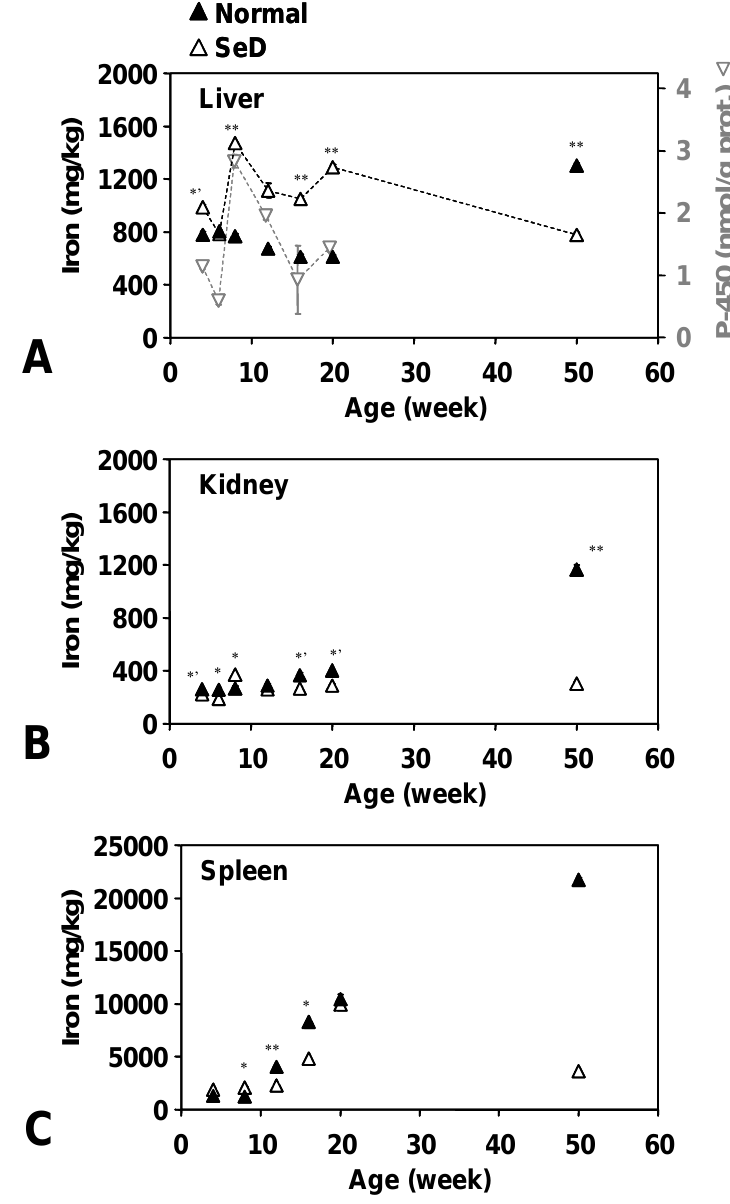
Figure 4. Dependence of Fe contents in the (A) liver, (B) kidney, and (C) spleen of normal and SeD rats on the age of rats. Values are indicated as the mean ± SD of three measurements. * , *’ , and ** indicate a significant difference between normal and SeD groups at p < 0.05, p < 0.01, and p < 0.001, respectively. Gray inverse triangles in (A) indicate cytochrome P-450 activity in the SeD rat liver microsome. Values are indicated as the mean ± SD of 3 measurements. Cytochrome P-450 activity of 50-week-old groups was not